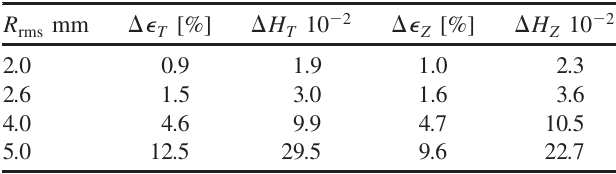
TABLE V. Beam size dependence—uniform beam, v ¼ 340 kV . R rms mm